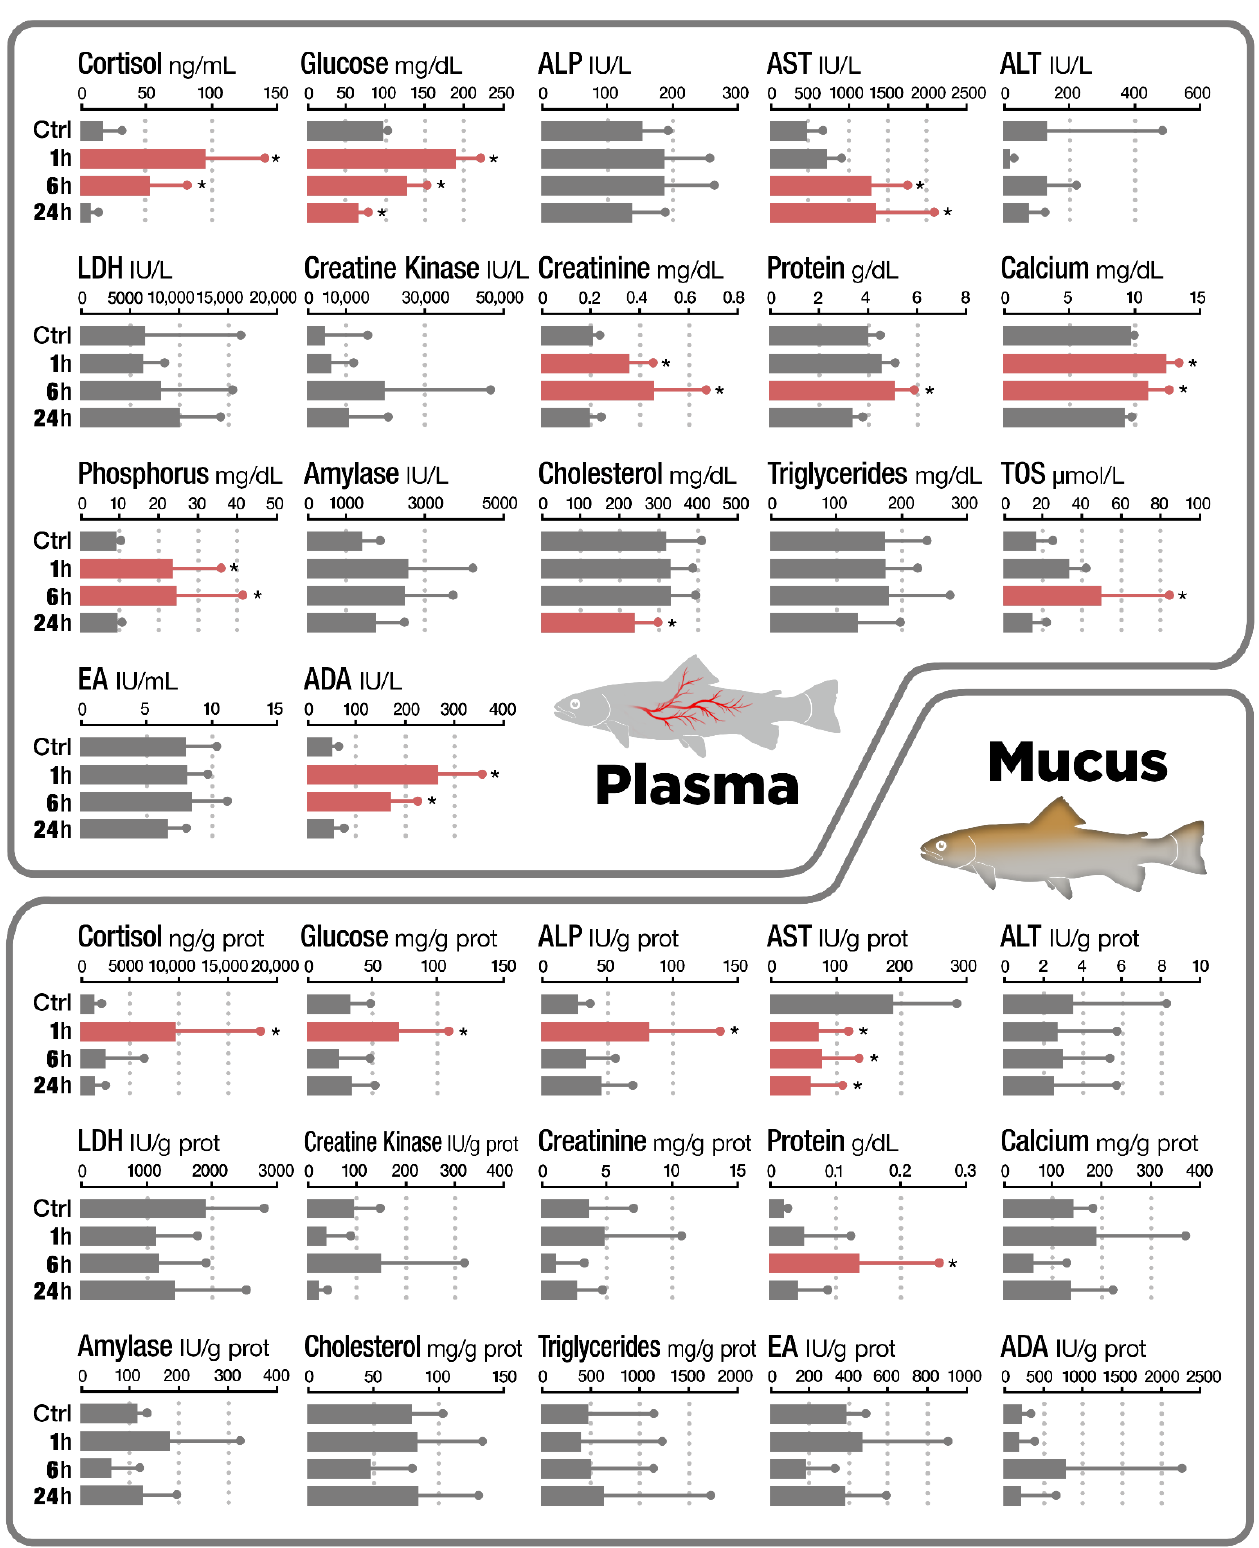
Figure 1. Biochemical parameters measured in plasma and skin mucus of rainbow trout after an acute stress, sampled 1, 6, and 24 h post-stressor. Values are presented as mean ± standard deviation ( n = 9). Data were analysed using a one-way ANOVA test, and all groups were compared with the control group ( p < 0.05). Significant differences are marked with an asterisk (*). Alkaline phosphatase (ALP), aspartate transaminase (AST), alanine aminotransferase (ALT), lactate dehydrogenase (LDH), total oxidative status (TOS), esterase activity (EA), and adenosine deaminase